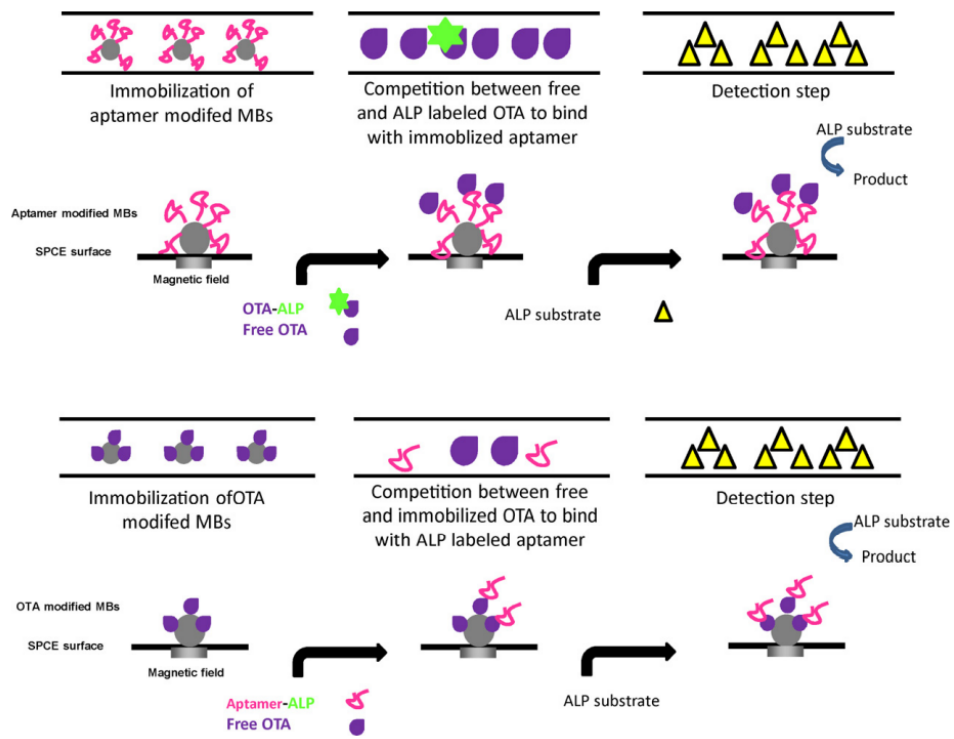
Figure 5. Schematic representation of e-principle for the automated flow-based electrochemical aptasensor using direct and indirect competitive formats. Reproduced from [44]. Copyright 2013